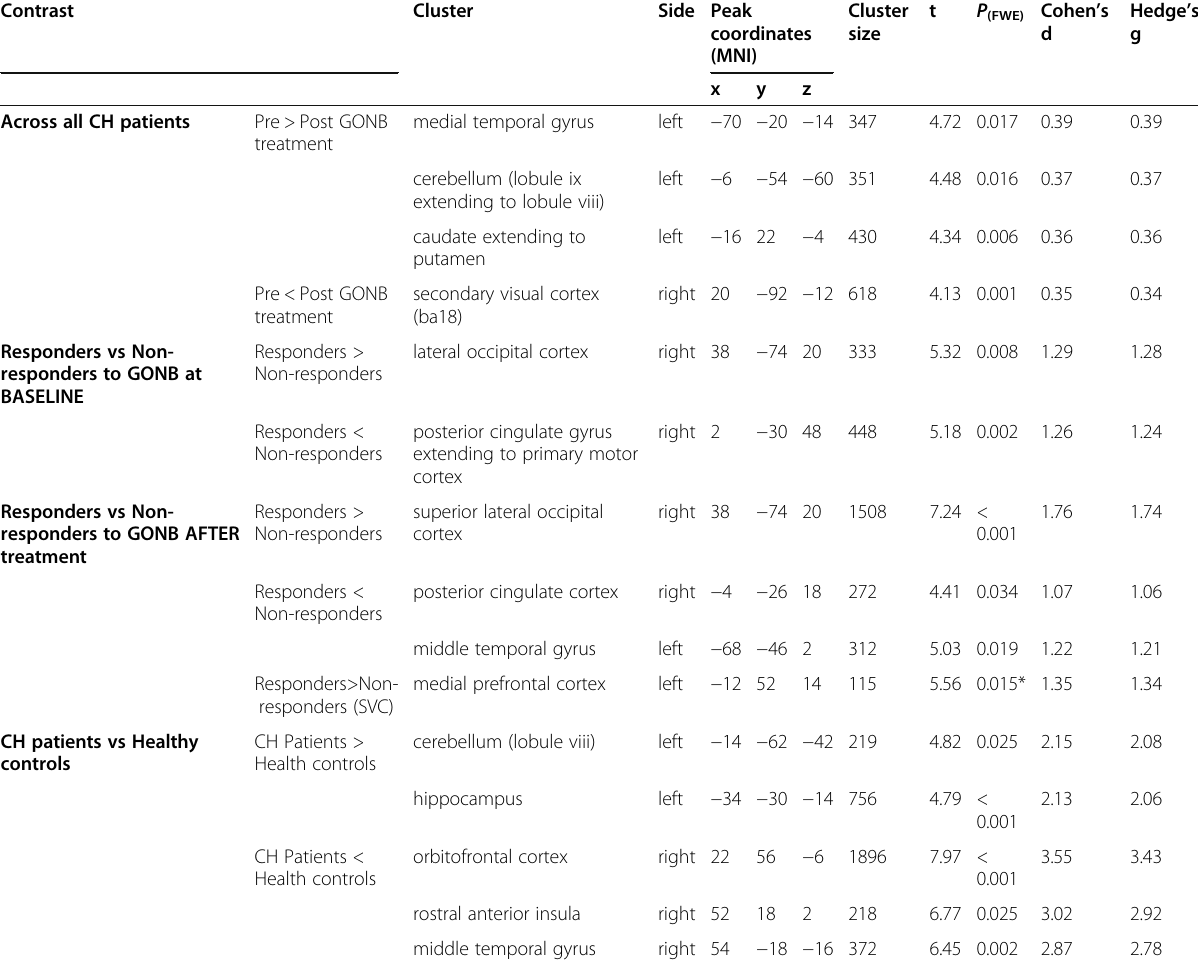
Table 3 Summary of peak coordinates across all contrasts